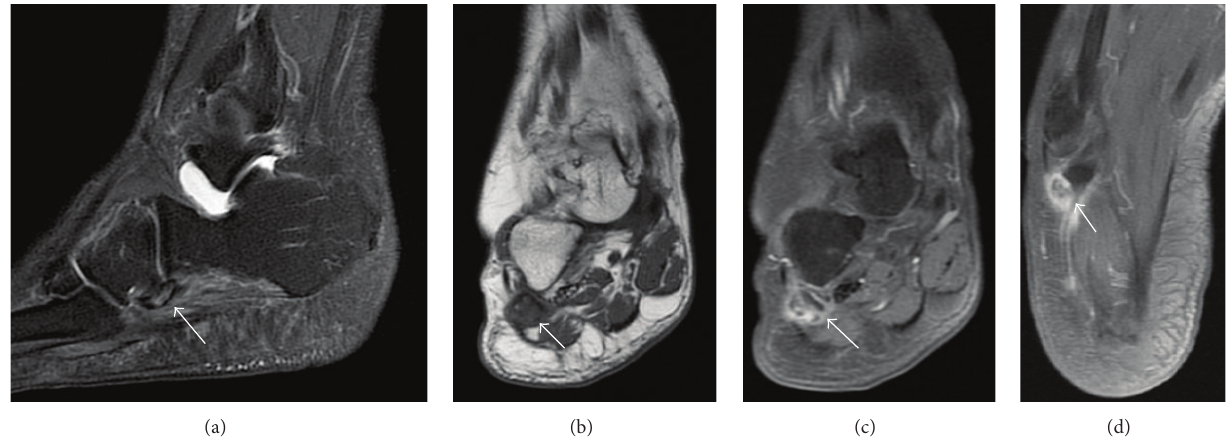
Figure 2: 60-year-old female right midfoot MRI. (a) Sagittal T2; (b) coronal T1; (c) fat suppressed T1 postgadolinium; and (d) axial fat suppressed T1 postgadolinium. Arrows show the os peroneum within the peroneal tendon, with irregular contours, bone marrow edema, and intense enhancement of the adjacent soft tissues, characterizing inflammatory changes. The peroneus longus tendon is thickened and heterogeneous, consistent with associated